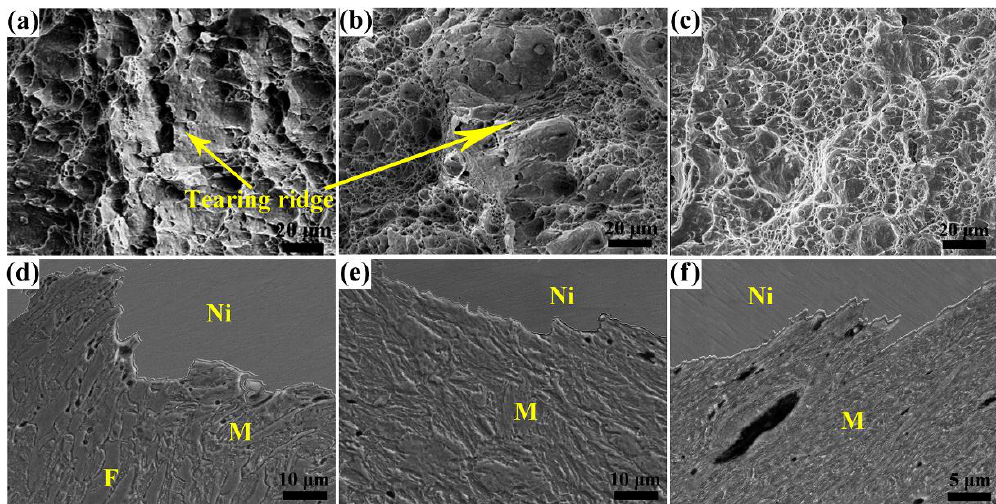
Figure 11. SEM images of the −40 °C impact fracture morphology and microstructure underneath the fracture surface of the specimens tempered at 450 °C with ferrite content of ( a , d ) 37 vol%, ( b , e ) 3 vol%, and ( c , f ) none, respectively.